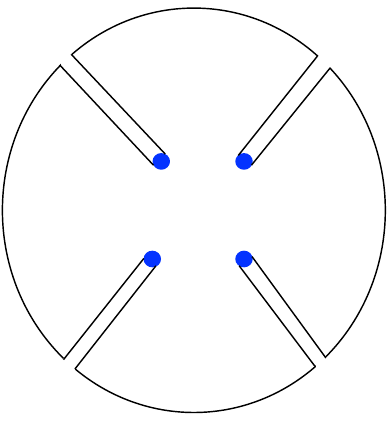
Figure 7 . Deformed Wilson lines with quark insertions immersed into the bulk provide semilocal observables for the worldsheet